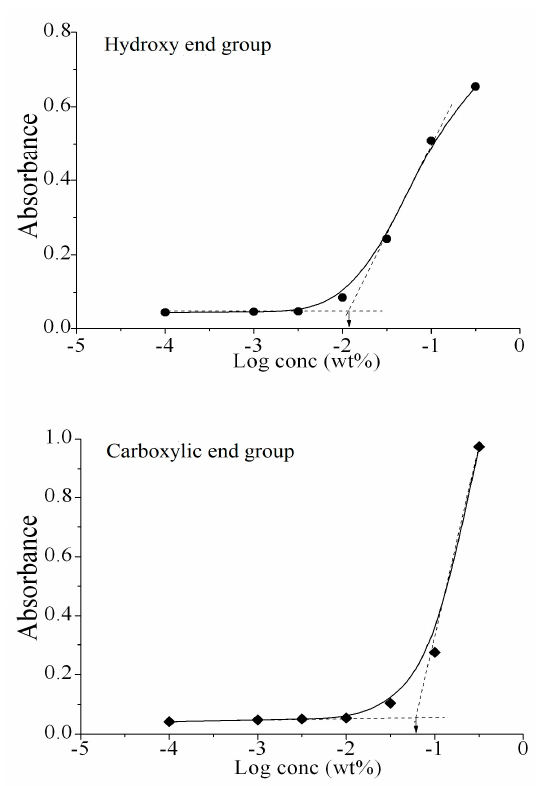
Figure 5. Critical micelle concentrations of hydroxyl terminated and carboxylic terminated PECP.